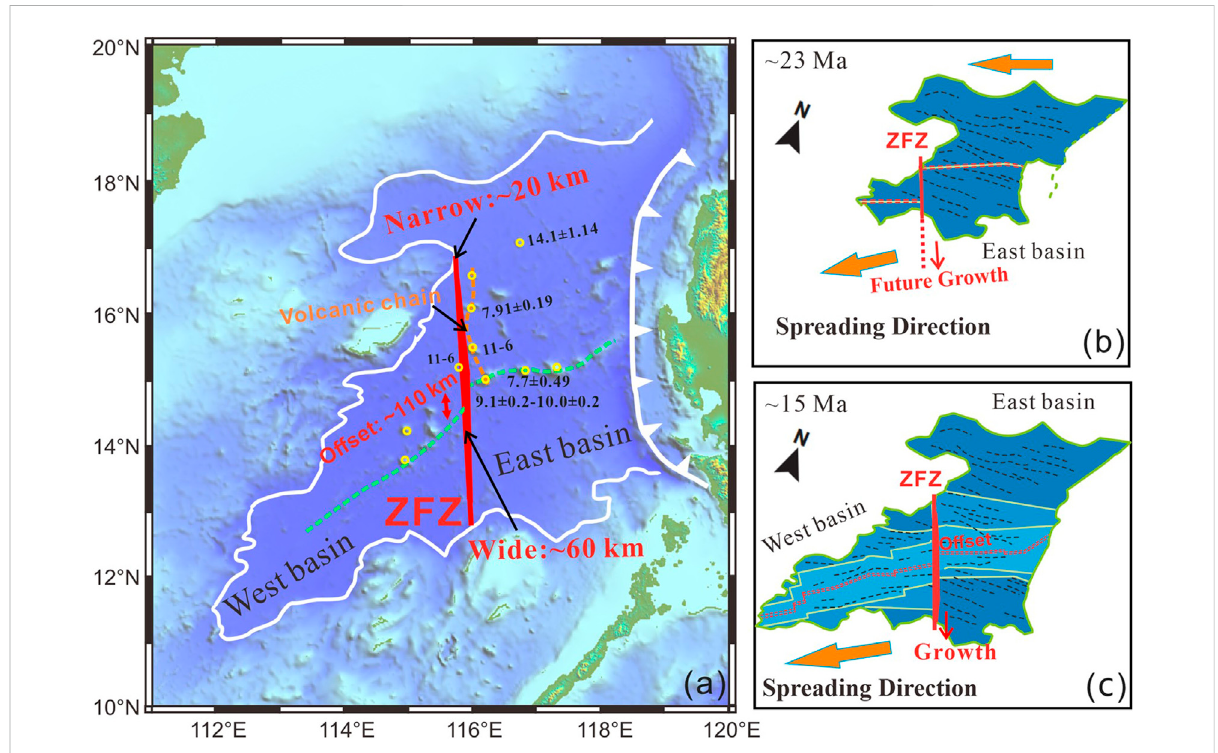
FIGURE 13 Plate reconstructions of the South China Sea basin at 23 and 15 Ma and post-spreading Seamounts distribution. (A) Schematic diagram of the South China Sea basin tectonics, the red line is the Zhongnan Fault Zone, the yellow dots represent sea seamounts. The seamount ages are from Pautotetal.,1990;Tongkul1993;Wangetal.,1985,Wangetal.,2009;Yanetal.,2008;Yanetal.,2008;Yanetal.,2014 (B – C) Platereconstructionsof theSouthChinaSeabasin(~23,15 Ma,fromSibuetetal.,2016),thereddashedlineisthemid-oceanridge,andtheredsolidlineistheZhongnan Fault